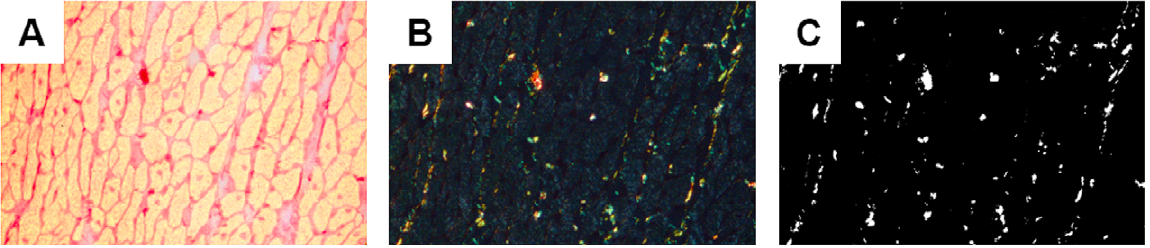
Fig. 3. This figure shows images used in the quantification of fibrosis using polarisation light microscopy. (A) Shows a typical example of a Picrosirius red stained section of myocardium. (B) Using polarisation filters, only polarised light is passed through which can be trans- ferred into (C) a binary image, used for calculation of the percentage fibrosis per area. (Colors are visible in the online version of the article;